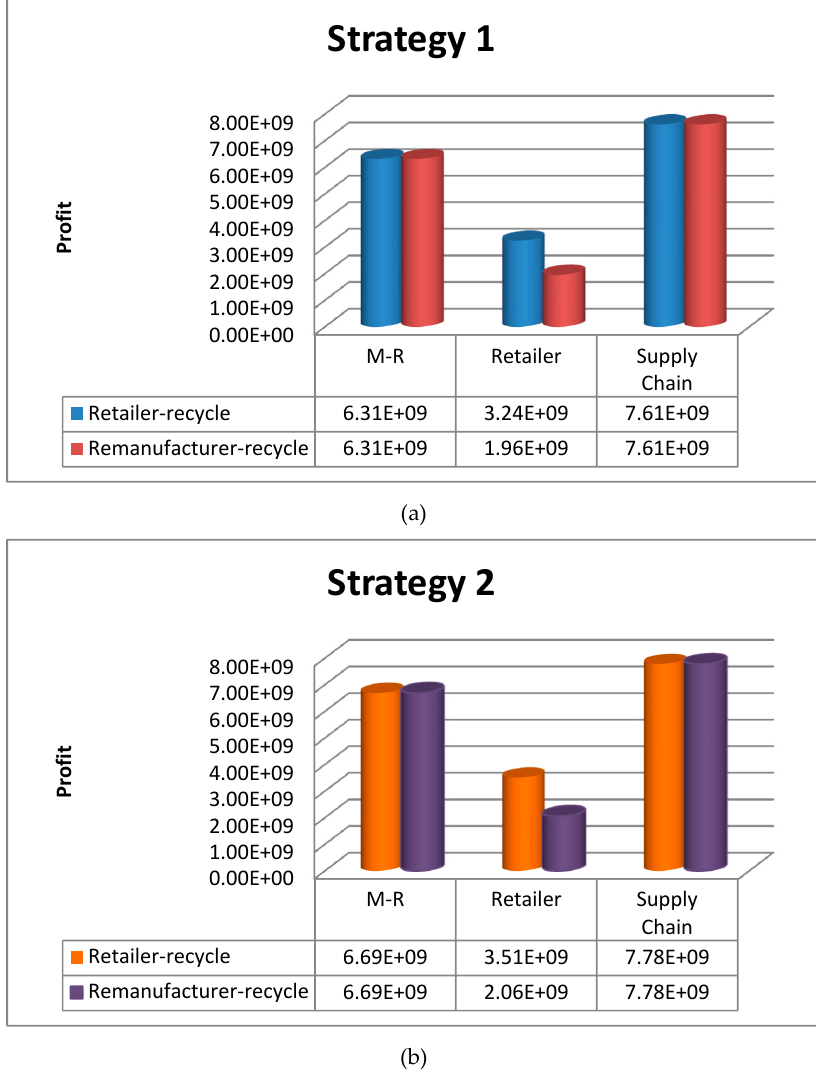
Figure 3. Retailer-recycle and Remanufacturer-recycle model comparison (horizontal comparison). ( a ) Comparisons in Strategy 1; ( b ) Comparisons in Strategy 2.